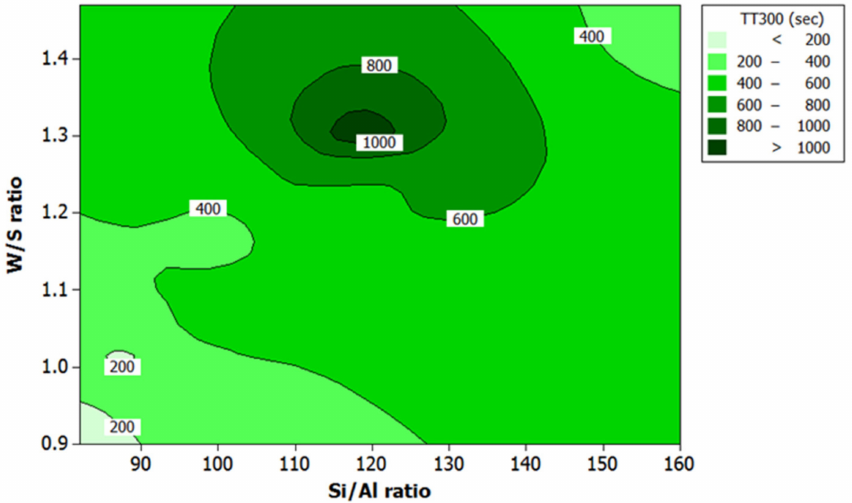
Figure 8. Contour plot for the effect of W/S ratio and Si/Al ratio on the TT300 in fire-retardant